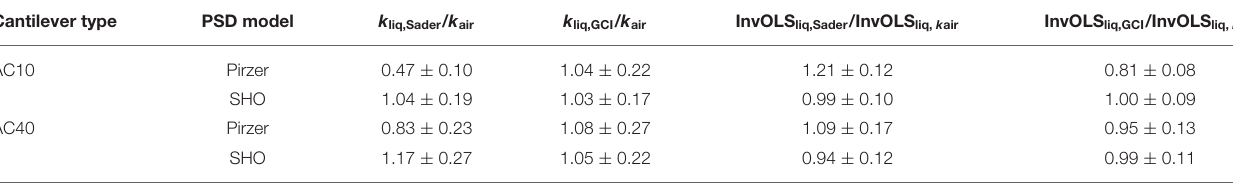
TABLE 3 | Summary of the normalized cantilever parameters in liquid. Cantilever